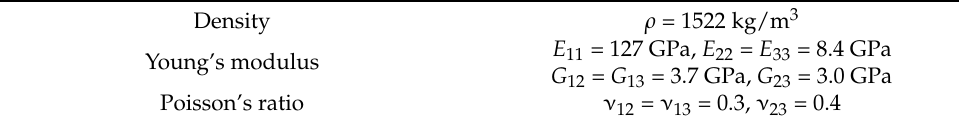
Table 1. Material parameters of carbon laminates [32].